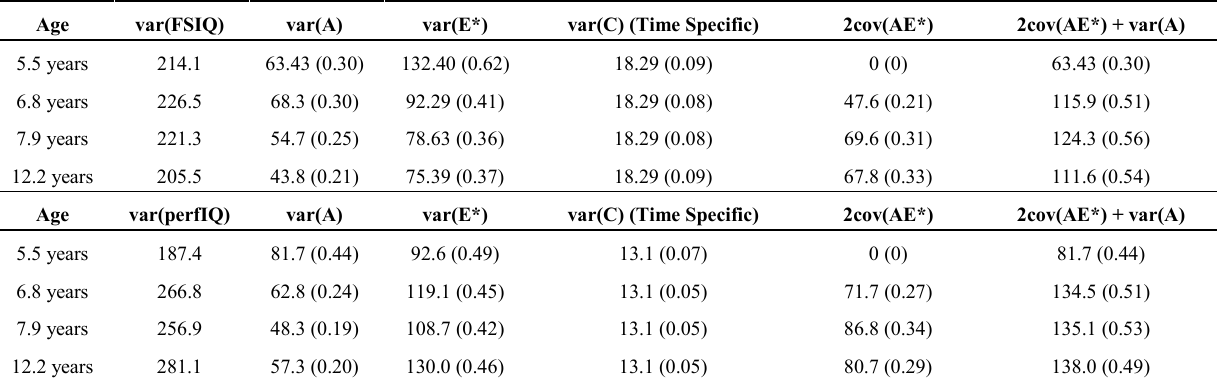
Table 3. Decomposition of phenotypic variance into A, E*, AE*-cov and C components. The standardized components are given in parentheses. Note that here var(E*) includes both var( ζ ) and var(e) and C is limited to time specific effects (var(c)). Additive genetic E time specific effects are